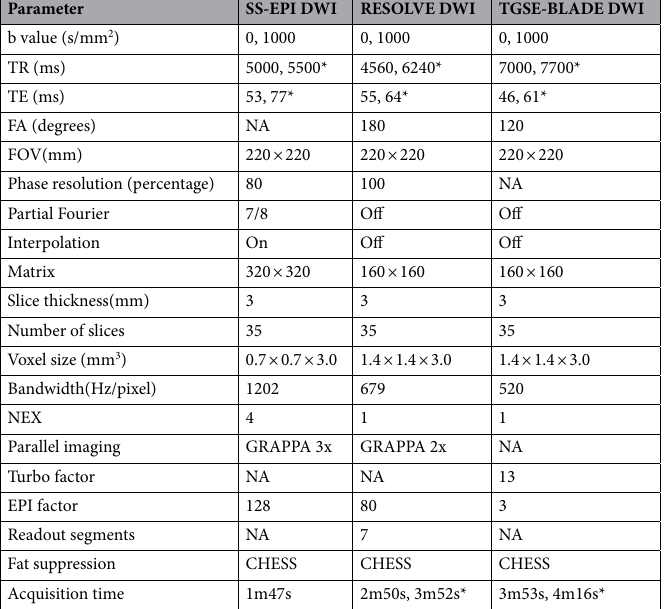
Table 1. Detailed imaging parameters for SS-EPI DWI, RESOLVE DWI, and TGSE-BLADE DWI. *Parameters for MAGNETOM Skyra. repetition time, TR; echo time, TE; flip angle, FA; field of view, FOV; number of excitations, NEX; echo planar imaging, EPI; chemical shift selective,